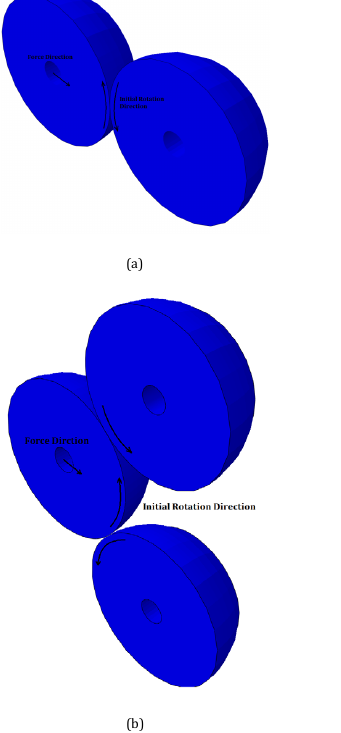
Figure 2. (a) QS and (b) BCC configurations. Symmetry conditions are imposed. Figure 2. QS (a) and BCC (b) configurations. Symmery conditions are imposed.